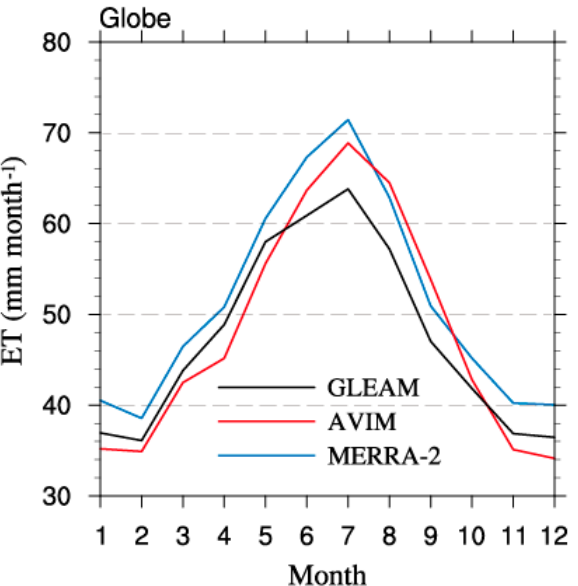
Figure 8. Annual cycle of the global area-weighted mean evapotranspiration (ET) for the AVIM. MERRA-2, and GLEAM datasets.